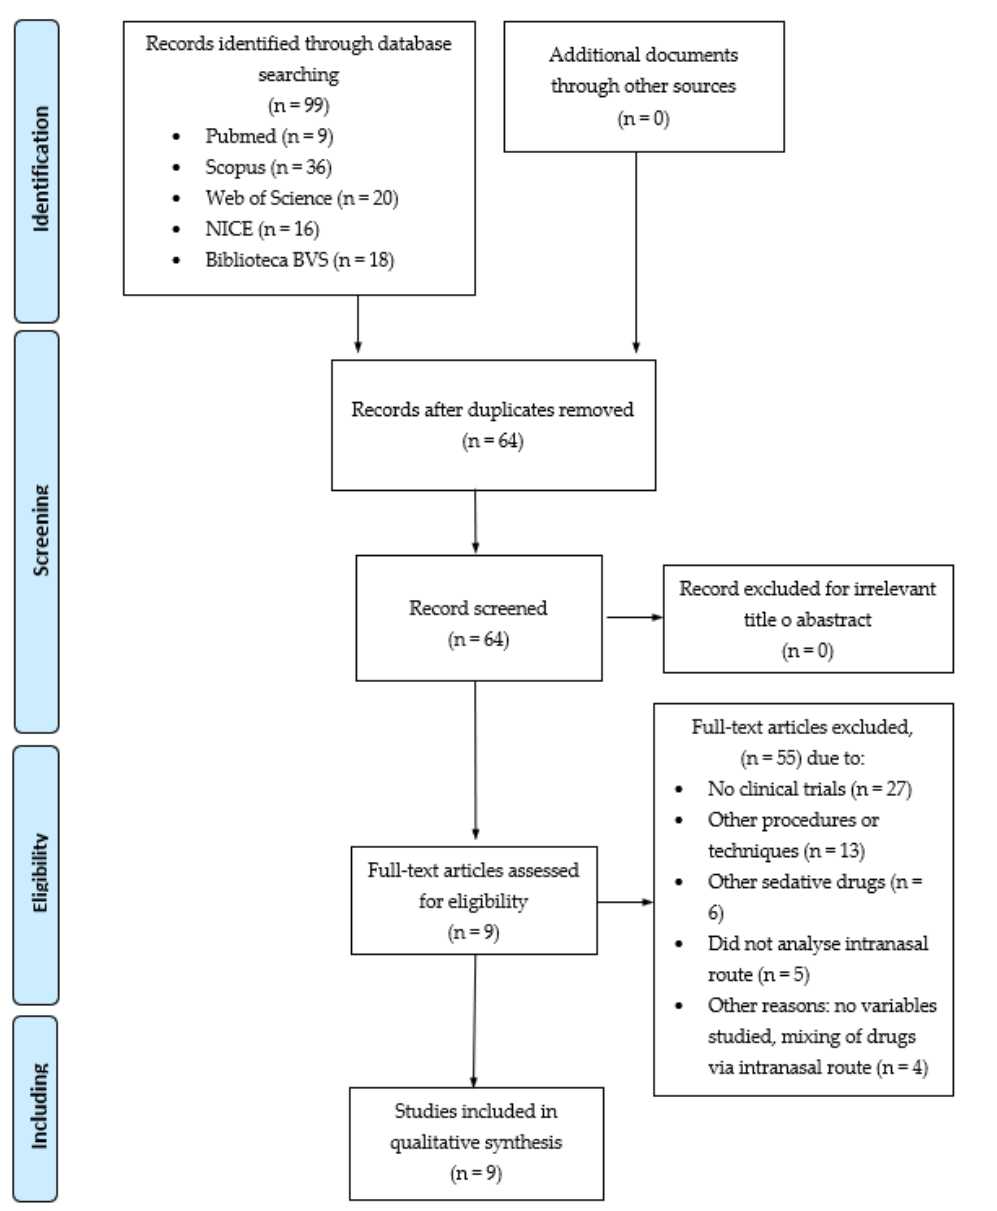
Figure 1. PRISMA flow chart (Moher et al., 2009) [17]